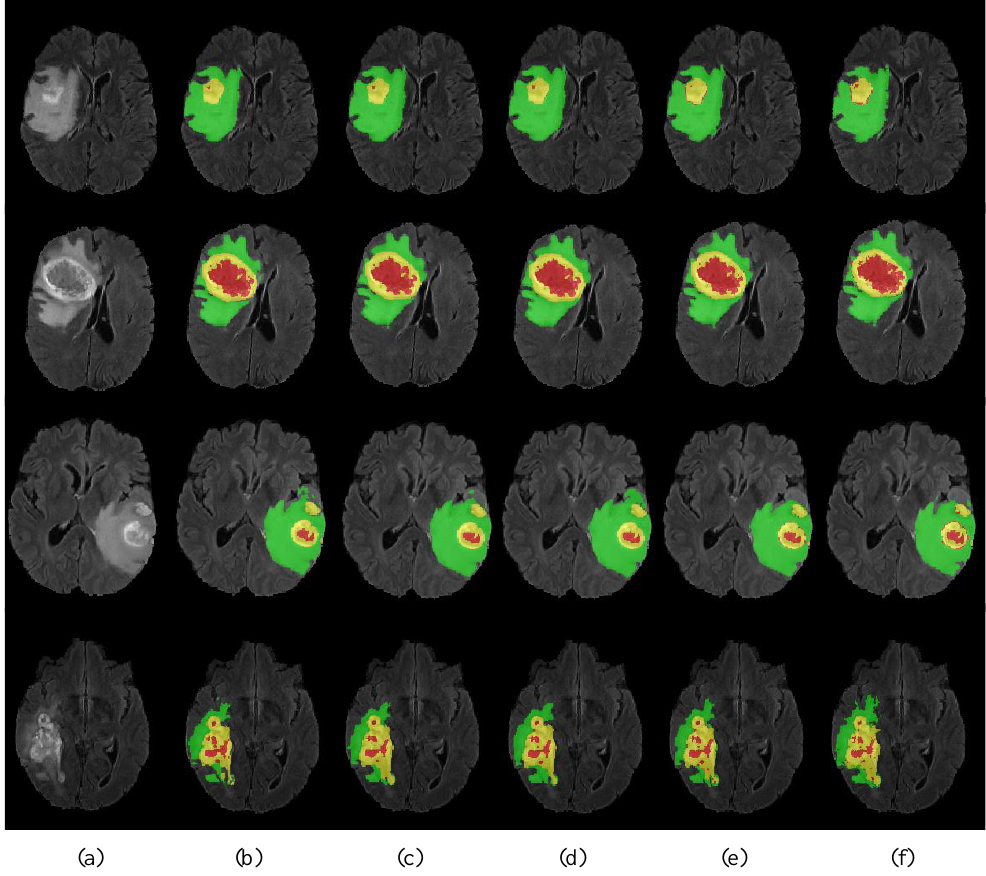
Figure 7. Visualization of segmentation results. Each row represents a different sample. ( a ) is the modality of Flair. ( b – f ) are the segmentation results of 3D Unet, DMF-Net, HDC-Net, HMNet, and ground truth. The red area is necrosis and non-enhancing, the yellow area is enhancing tumor, and the green area is